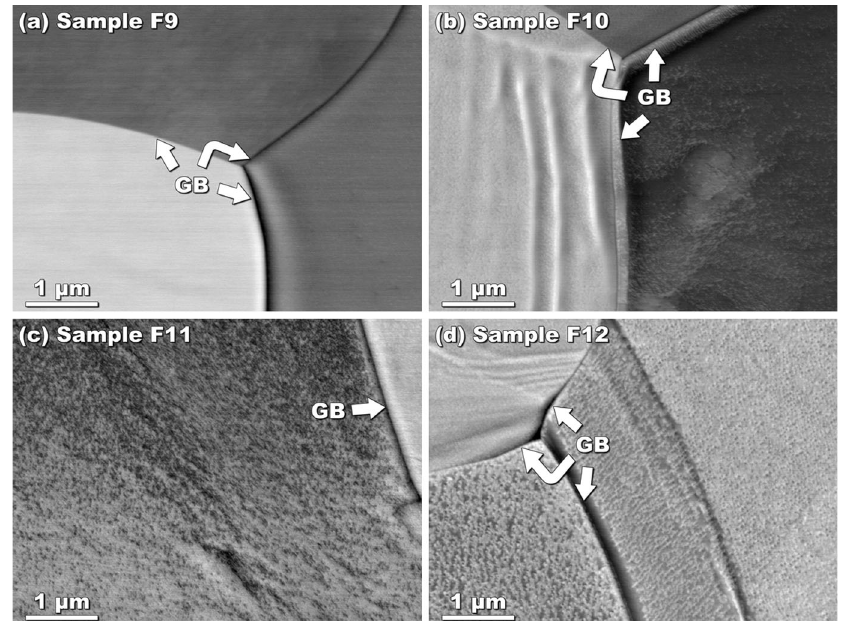
FIG. 5. Representative high magnification BSE image coupon sample surfaces with grain boundaries (GB) after different heat treatments, (a) 800 °C = 3 h with no nitrogen infusion and (b) – (d) are low temperature nitrogen infused at 120, 140 and 160 °C,